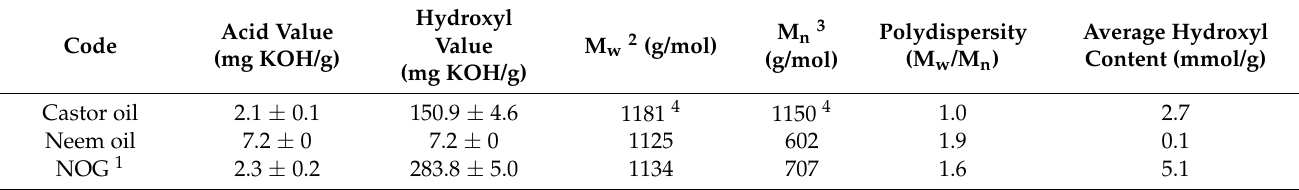
Table 2. The basic properties of castor oil, neem oil and